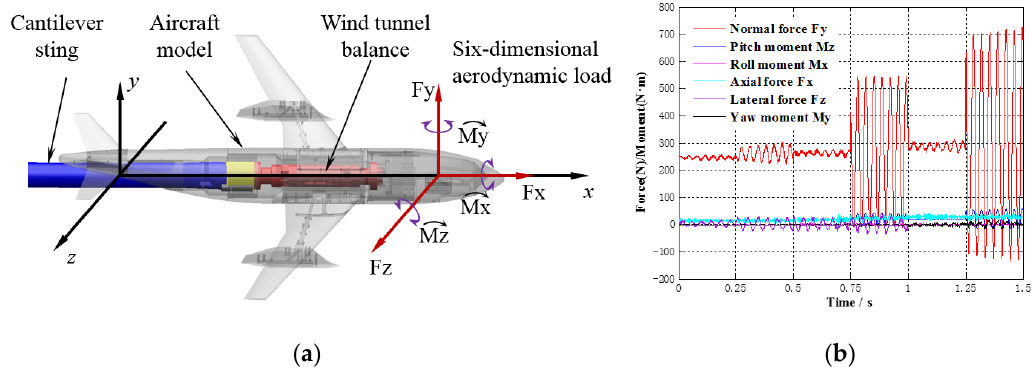
Figure 1. Stochastic multidimensional vibration of an aircraft model. ( a ) Definition of six-dimensional aerodynamic load. ( b ) Multidimensional vibration of an aircraft model.